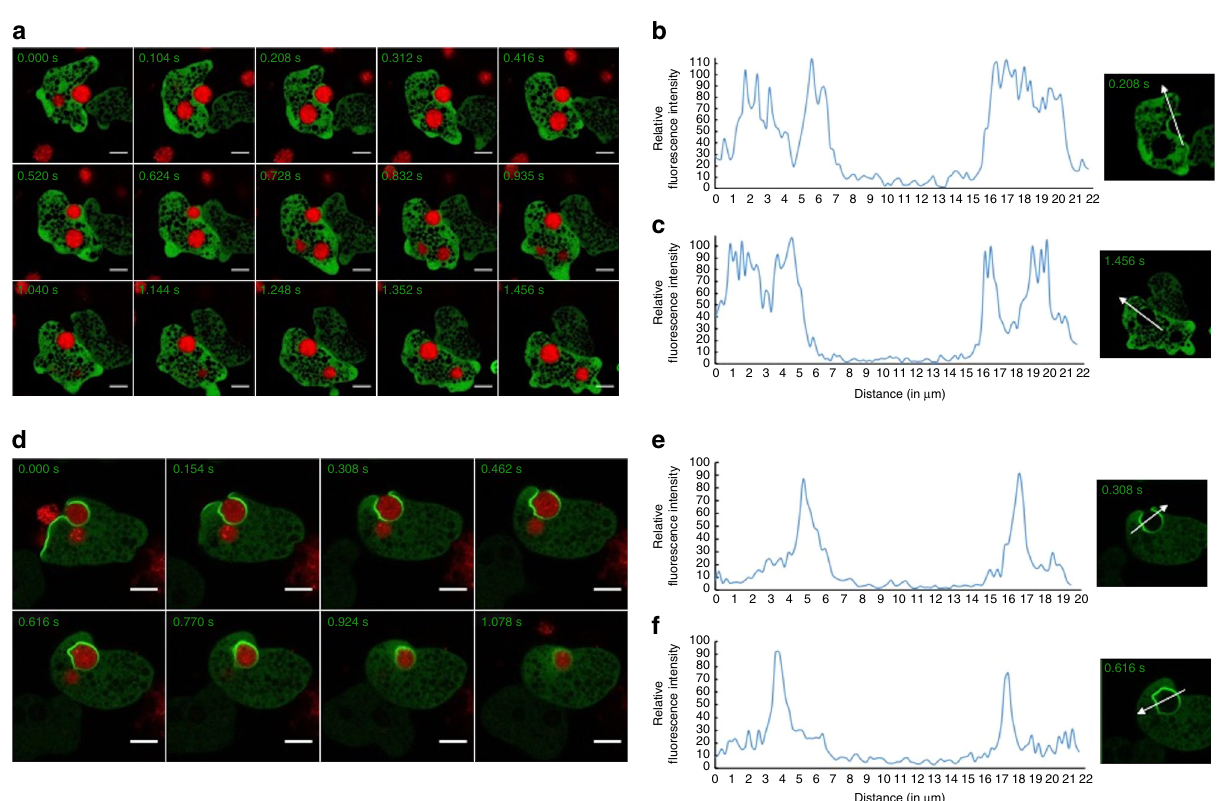
Fig. 8 Time series montage showing localization of GFP-EhAGCK1 and -EhAGCK2 during phagocytosis of pre-killed CHO cells. a Live cell imaging montage showing phagocytosis of pre-killed labelled CHO cells by GFP-EhAGCK1-expressing trophozoites ( Scale bar , 5 μ m). b , c Plot showing intensity of GFP-EhAGCK1 along the line drawn across the phagocytosis cup b and newly formed phagosome c . d Montage showing time series of GFP-EhAGCK2 expressing trophozoites phagocytosing pre-killed labelled CHO cells. e , f Intensity of GFP-EhAGCK2 along the line drawn across phagocytic cup e and newly formed phagosome f . ( Scale bar , 10 μ